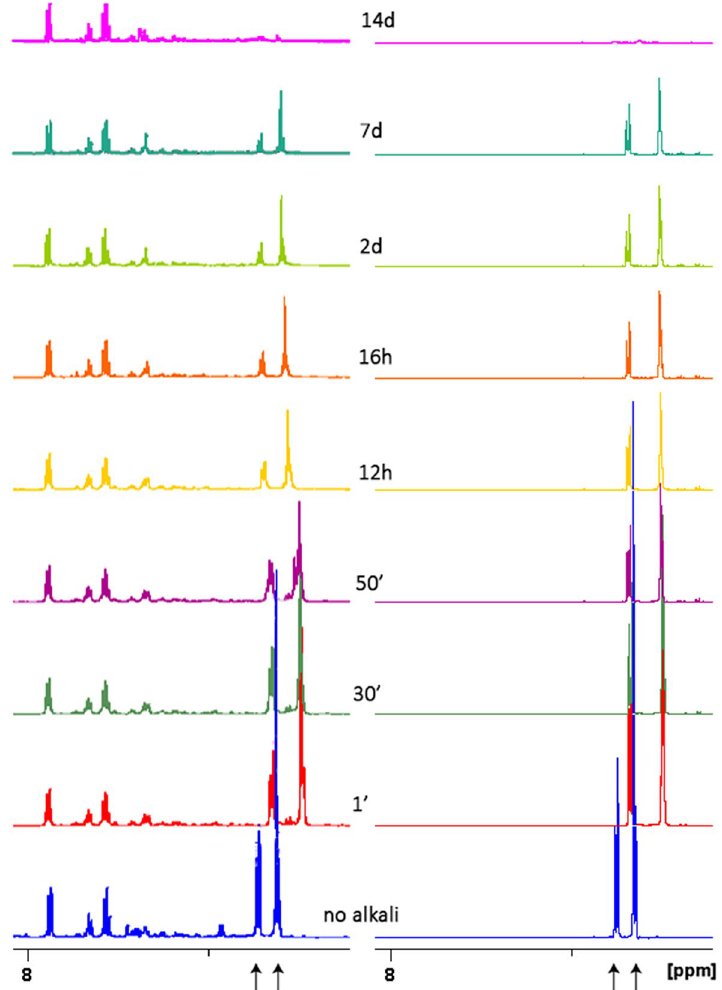
Figure 3. Reaction under alkaline condition monitored by 1 H spectroscopy for a urine sample (left panel) and HGA solution (right panel) up to 14 days: from bottom to top, spectra acquired before alkalinisation, then after 1’, 30’, 50’, 12 h, 16 h, 2d, 7d, 14d, are shown (aromatic segment); the same rate of signal weakening for HGA peaks (marked with arrows) down to the noise level is apparent for both samples. HGA solution was made at the same concentration of the metabolite in the urine sample, differences in peaks shape arise from the different viscosity of the